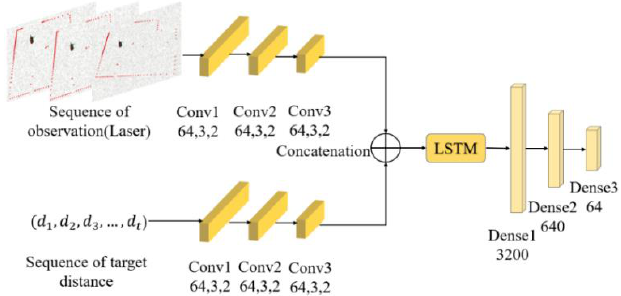
Figure 3. Encoder network structure. Every one-dimensional convolutional layer is represented by its channel size, kernel size and stride size. Other layers are represented by their types and dimensions.